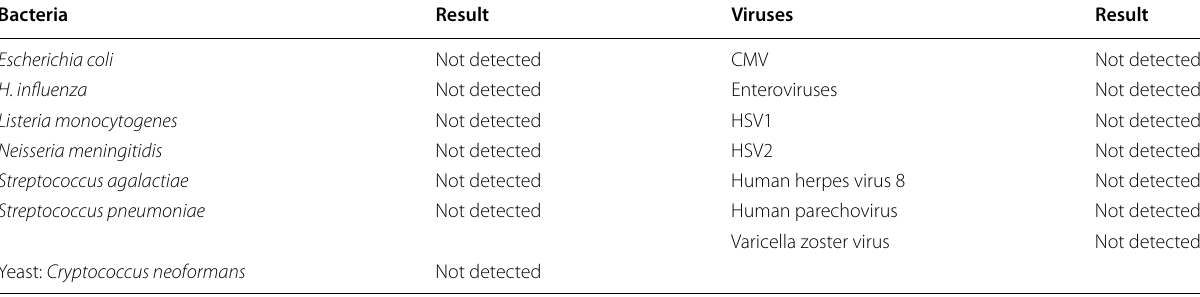
Table 4 Patient management Therapy and dosage for anti-NMDAR encephalitis Intravenous immunoglobulins (IVIG:0.4 g/kg iv daily for 5 days followed by: Prednisolone 1 mg/kg/day in a tapering